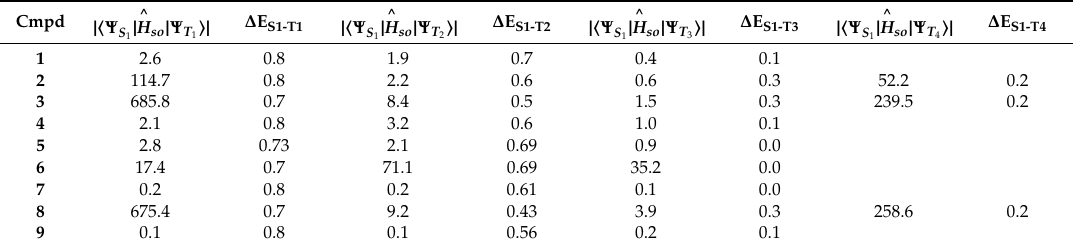
Table 2. Spin–orbit matrix elements (cm − 1 ) and singlet-triplet energy gaps (eV) calculated at the B3LYP / 6-31G(d) level of